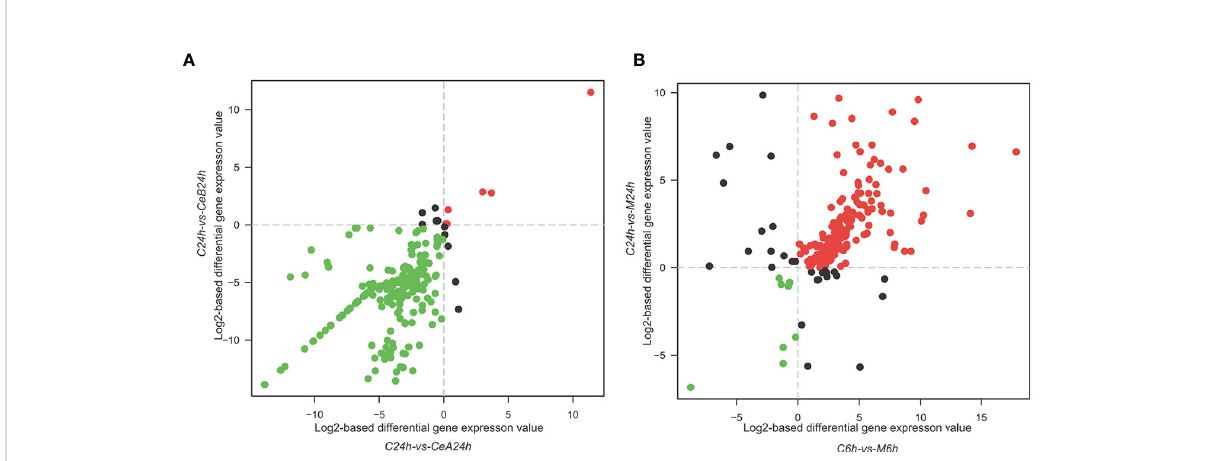
FIGURE 6 Comparison of gene expression during paclitaxel biosynthesis (GO:0042617) under different elicitation conditions. (A) The difference in gene expression of paclitaxel biosynthesis with 1 mM Ce 3+ and 1 mM Ce 4+ elicitation for 24 hours respectively. (B) The difference in gene expression of paclitaxel biosynthesis with 100 m M MJ elicitation for 6 and 24